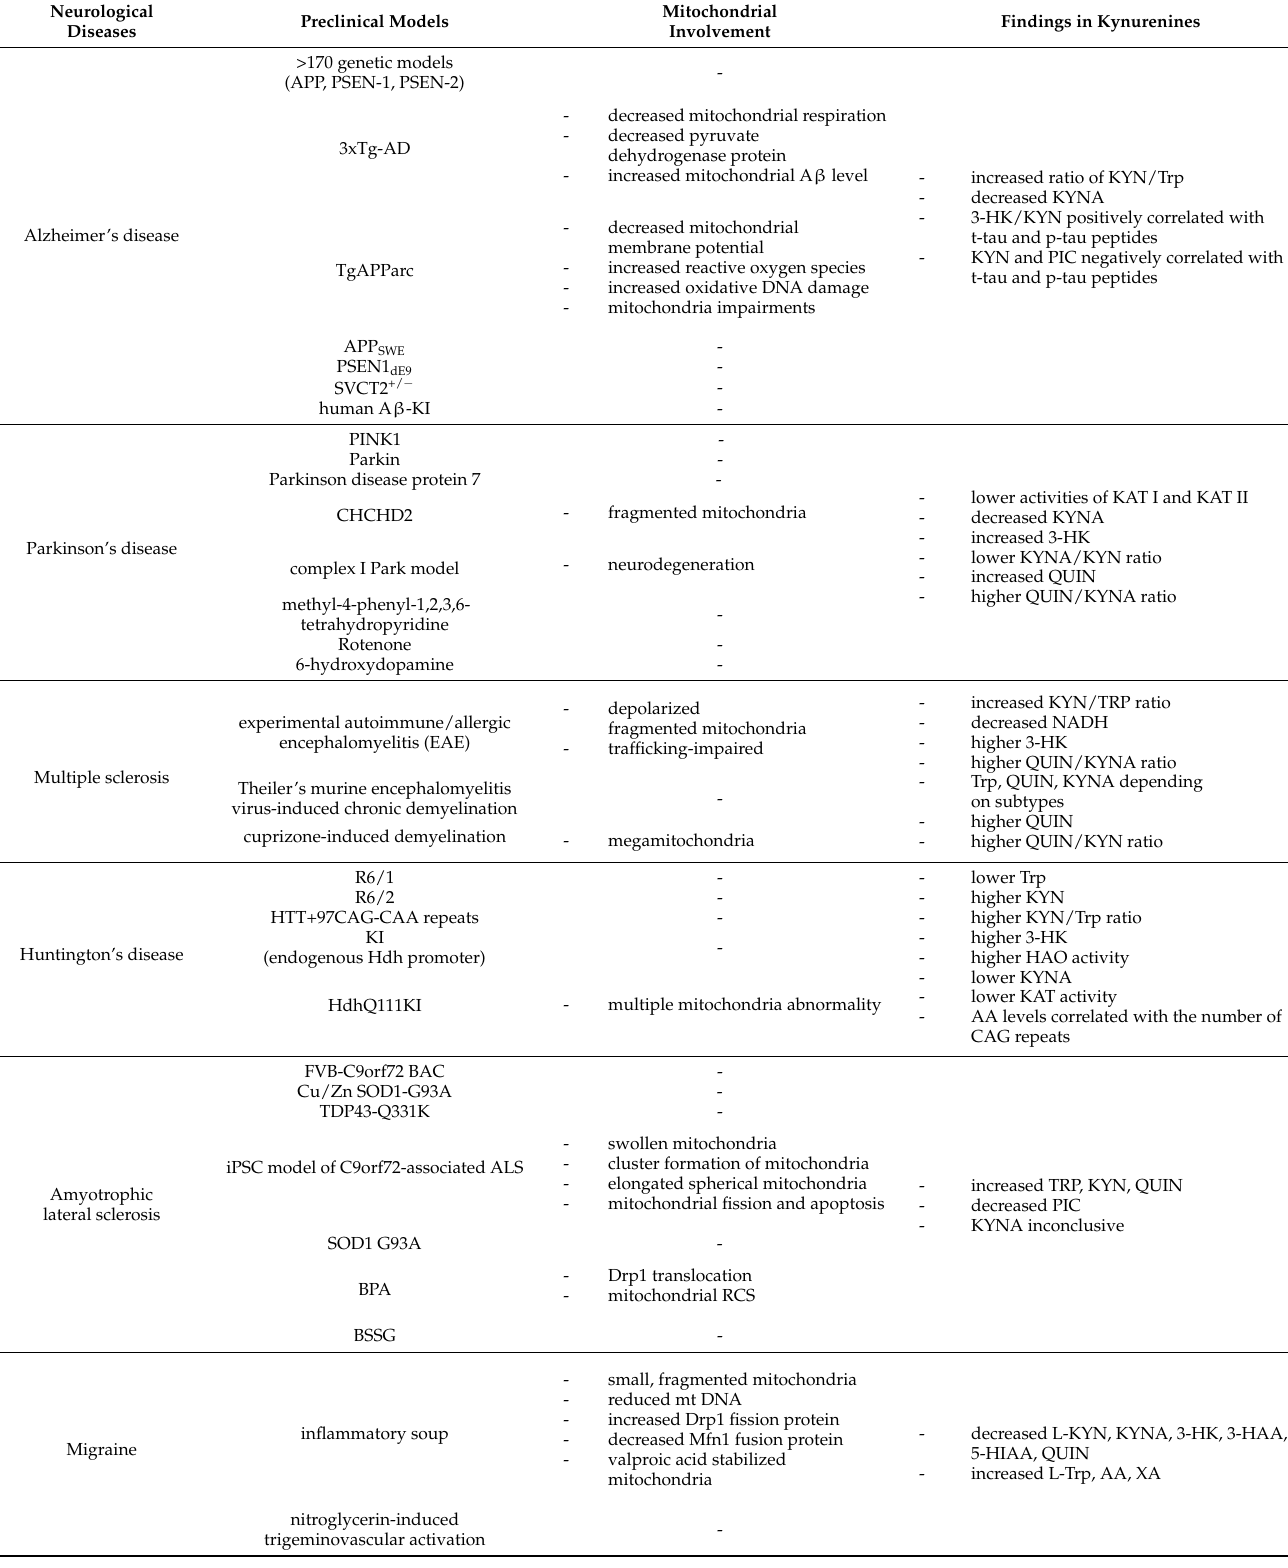
Table 2. The preclinical models, mitochondrial involvement, and findings in kynurenines in main neurological